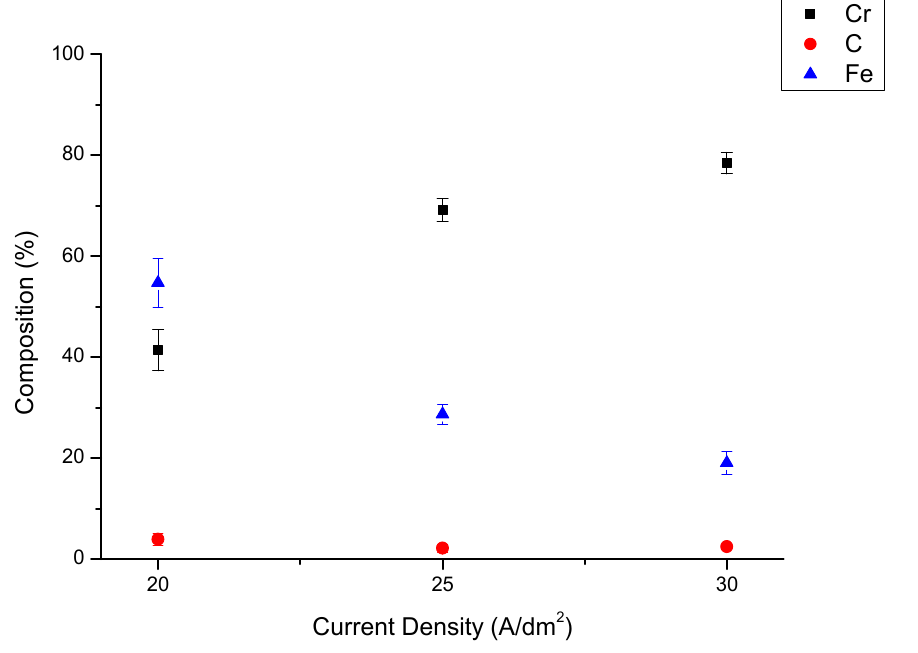
Figure 1. Concentrations of Fe, Cr and C in the Cr-Fe-C alloy deposits prepared in the Cr 3+ -based electroplating bath with Fe 2+ ions.